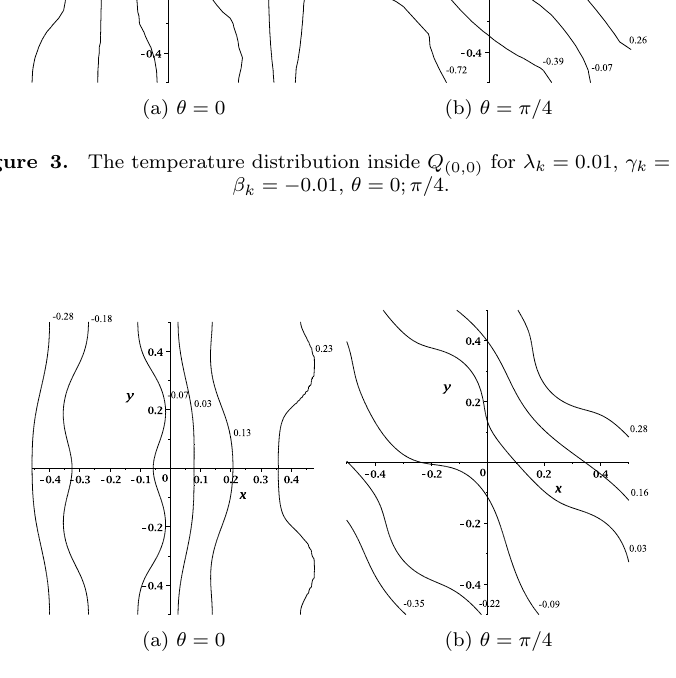
Figure 4. The temperature distribution inside Q (0 , 0) for λ k = 100, γ k = 100, β k = − 0 . 01, θ = 0; π/